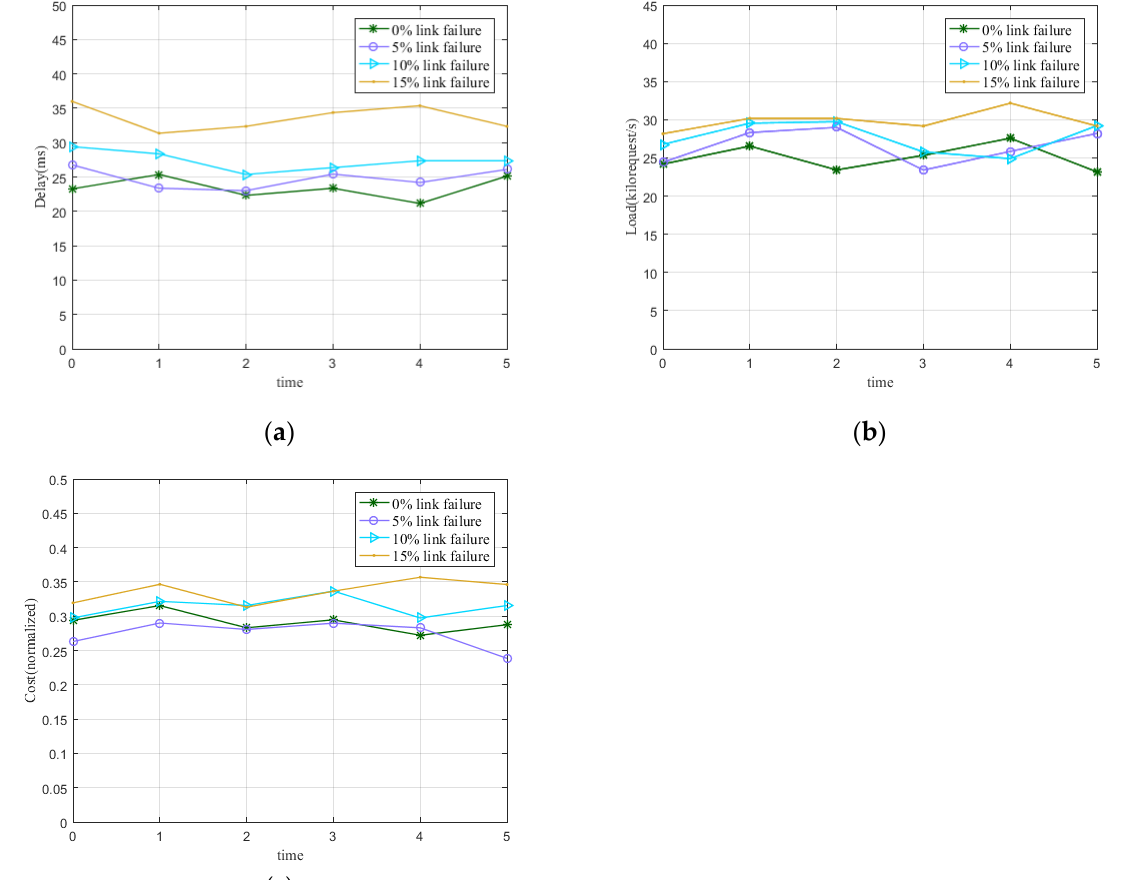
Figure 3. Performance evaluation of different time periods after 0%, 5%, 10%, and 15% link failures in Bellcanada topology. ( a ) Performance of different link failures in terms of delay. ( b ) Performance of different link failures in terms of load rate. ( c ) Performance of different link failures in terms of link overhead.